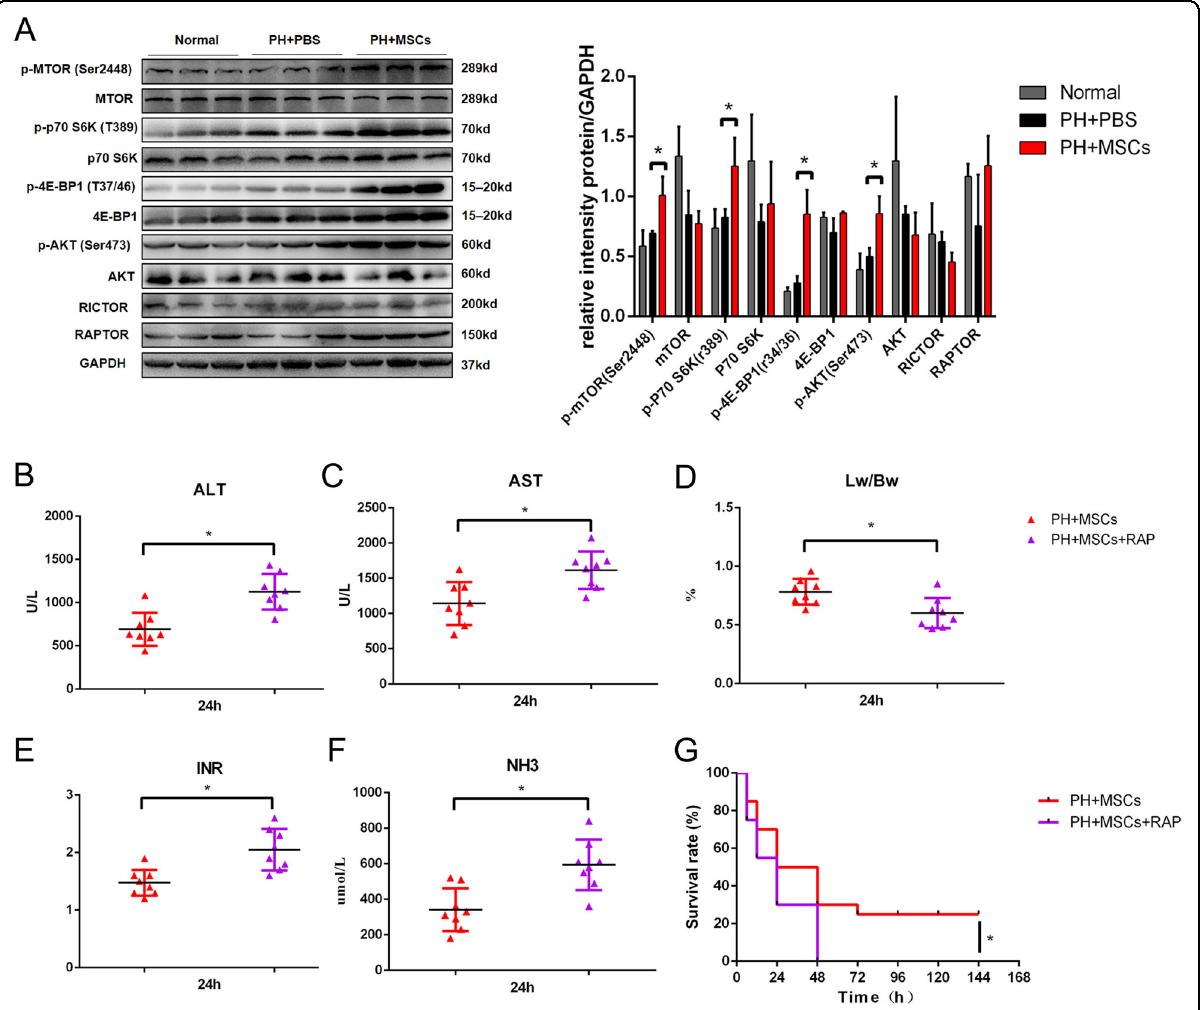
Fig. 4 MSCs transplantation improves the mTOR pathway after hepatectomy. A Western blotting analysis of mTOR pathway. B , C , E , F The levels of serum ALT, AST, PT, and ammonia were determined at 24 h. D The ratio of liver to body weight. G Survival analysis of PHLF rats. * P < 0.05. t -test, data are shown as mean standard